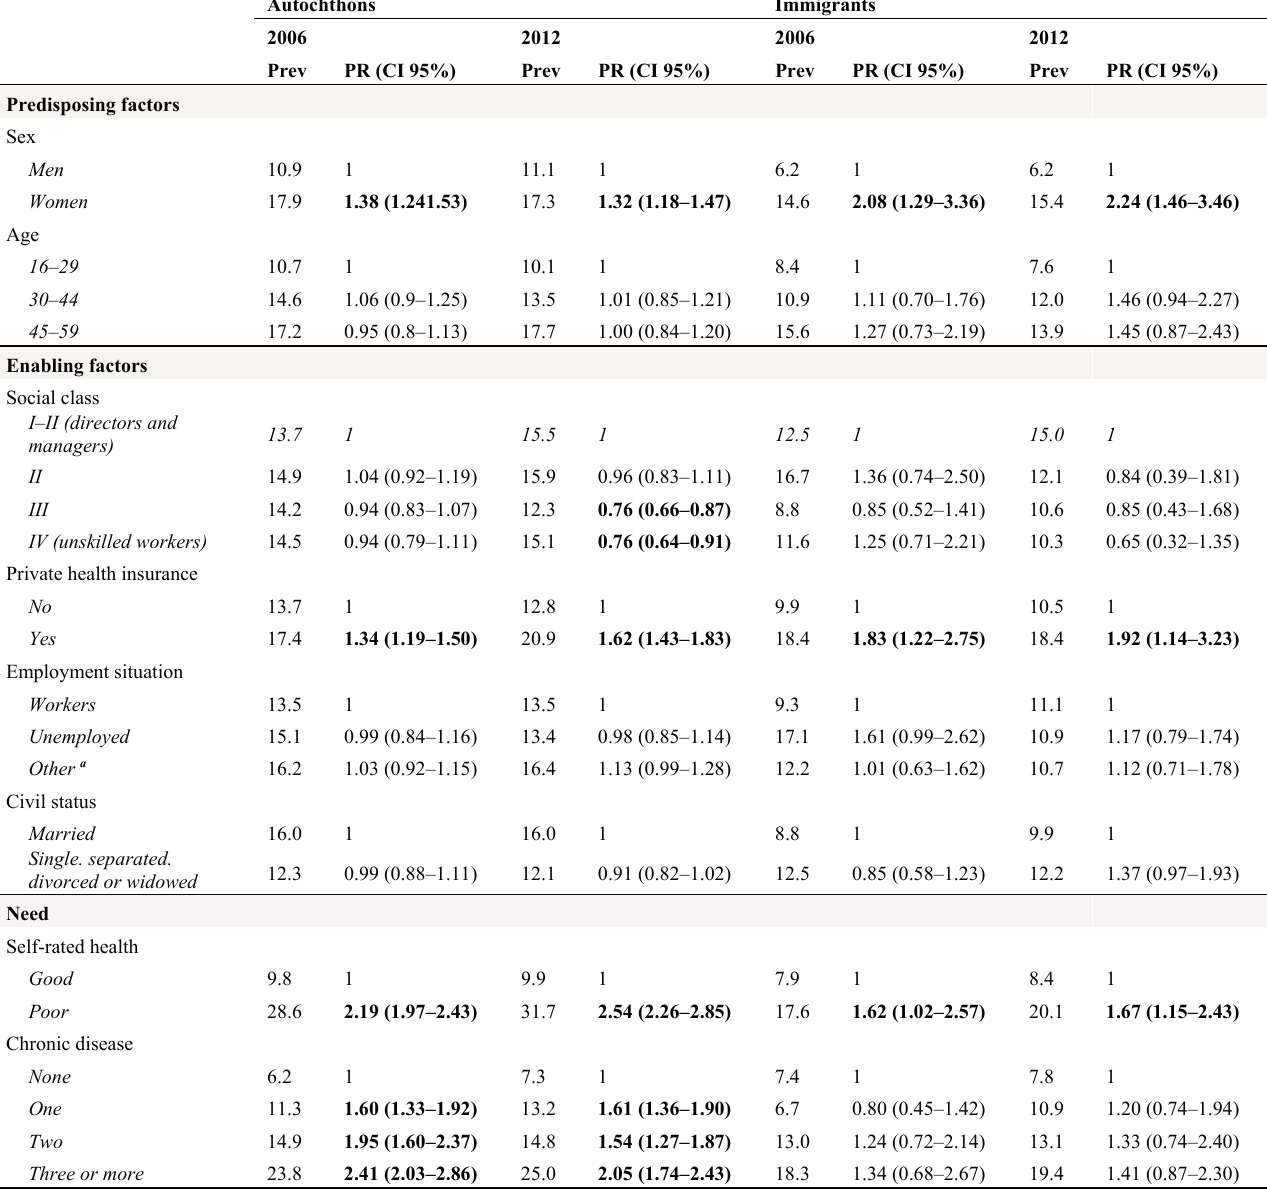
Table 4. Determinants of specialist visits in autochthons and immigrants in 2006 and